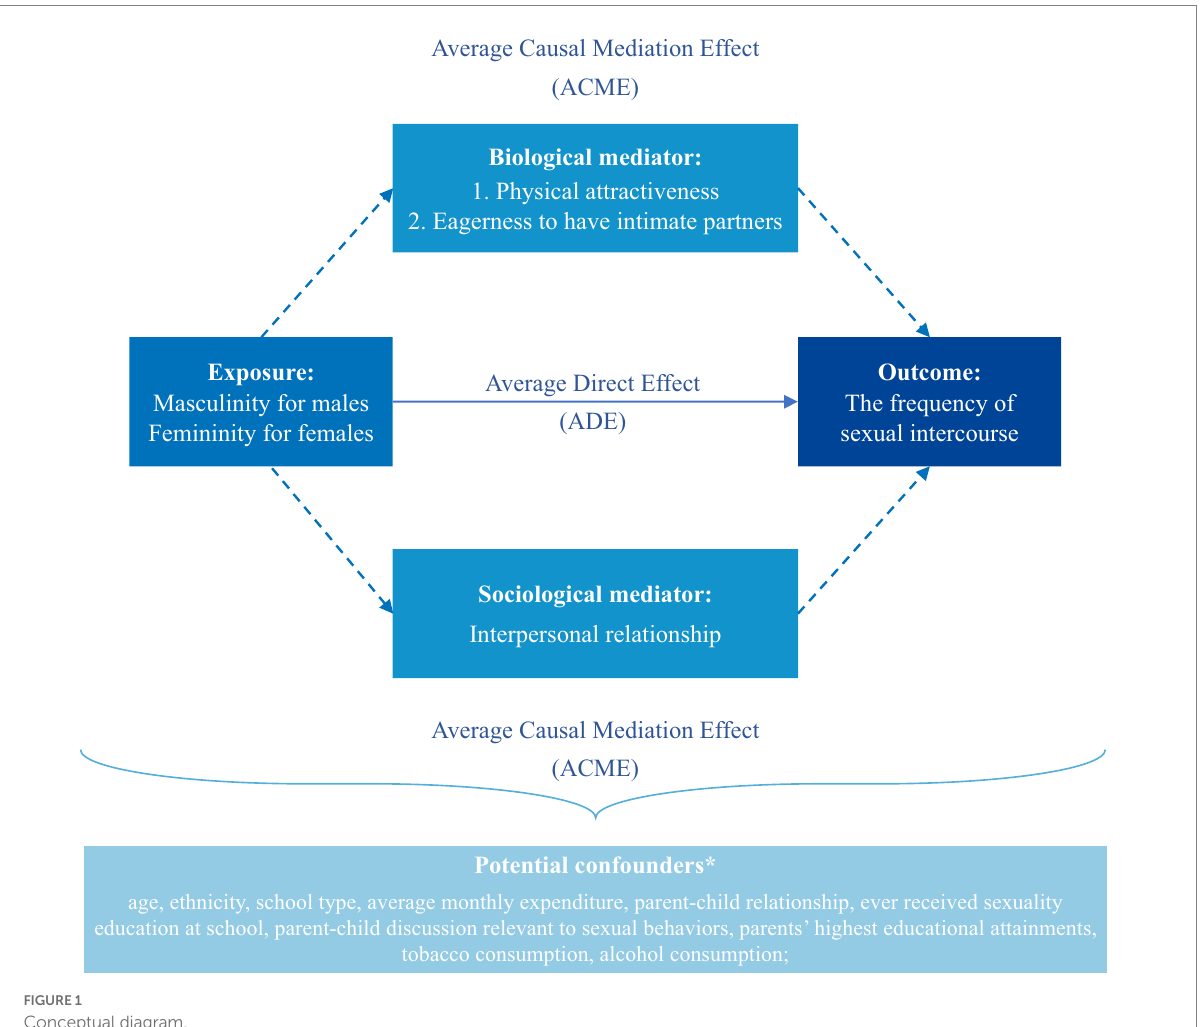
FIGURE 1 Conceptual